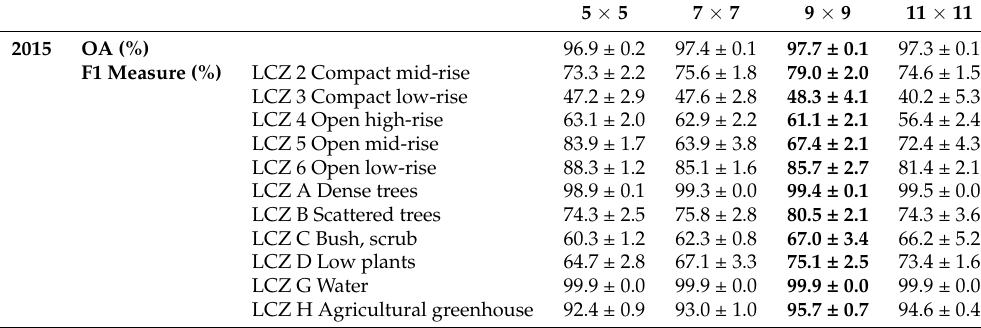
Table A1. Overall accuracies (%) and F1-scores (%) of the LCZ maps with kernel size 5 × 5, 7 × 7, 9 × 9 and 11 × 11 for 2005, 2011 and 2017. The accuracy metrics for the kernel sizes with the largest OA score per year are indicated in